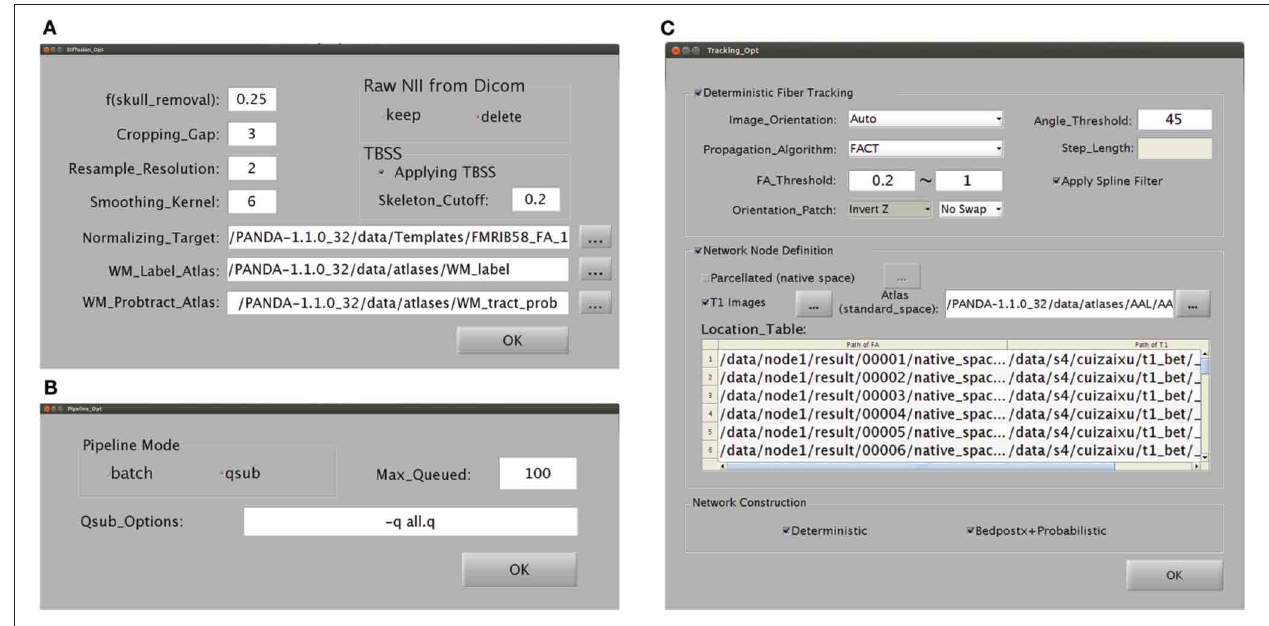
analysis. (B) A snapshot of the GUI for changing the computing modes of PANDA. (C) A snapshot of the GUI for changing the parameters used to construct anatomical brain networks.